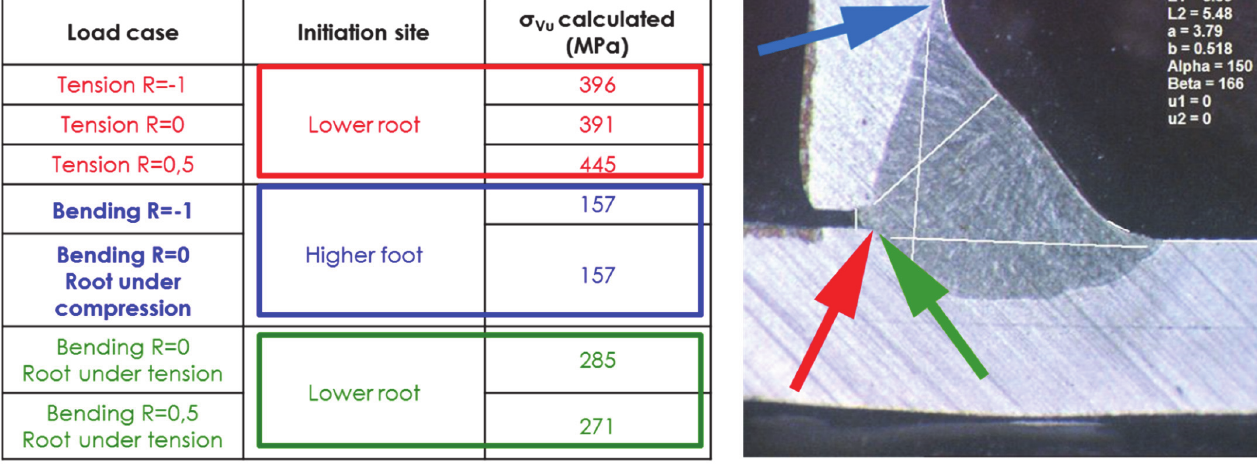
Figure 8: Fatigue stress (Vu criterion) computed at the hot spot for constant amplitude